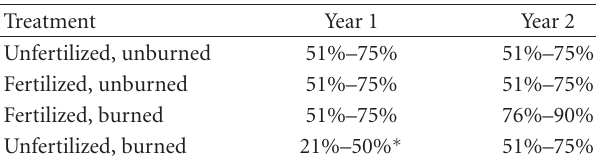
Table 1: Percent of ground cover classes by fertilization and burning treatments within the first two posttreatment years, cherokee ridge and sweet union research sites combined, east Texas, USA. ∗ significantly di ff erent within column at P = .1 from analysis of various test proc GLM (SAS, ver 8).